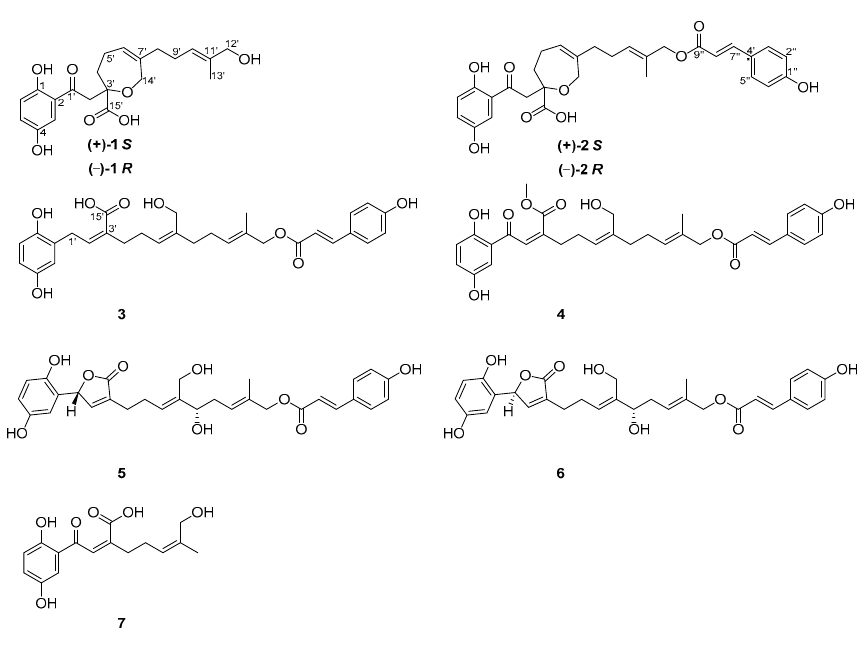
Figure 1. The structures of compounds 1 – 7 .